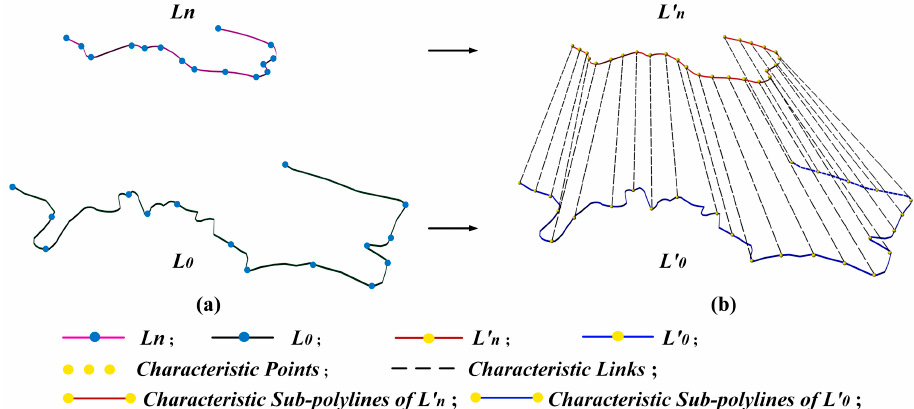
Figure 2. Characteristics between the initial contour L 0 ( L (cid:48) 0 ) and target contour L n ( L (cid:48) n ) . ( a ) Initial contour L 0 and target contour L n . ( b ) Characteristics between the initial contour L (cid:48) 0 and target contour L (cid:48) n